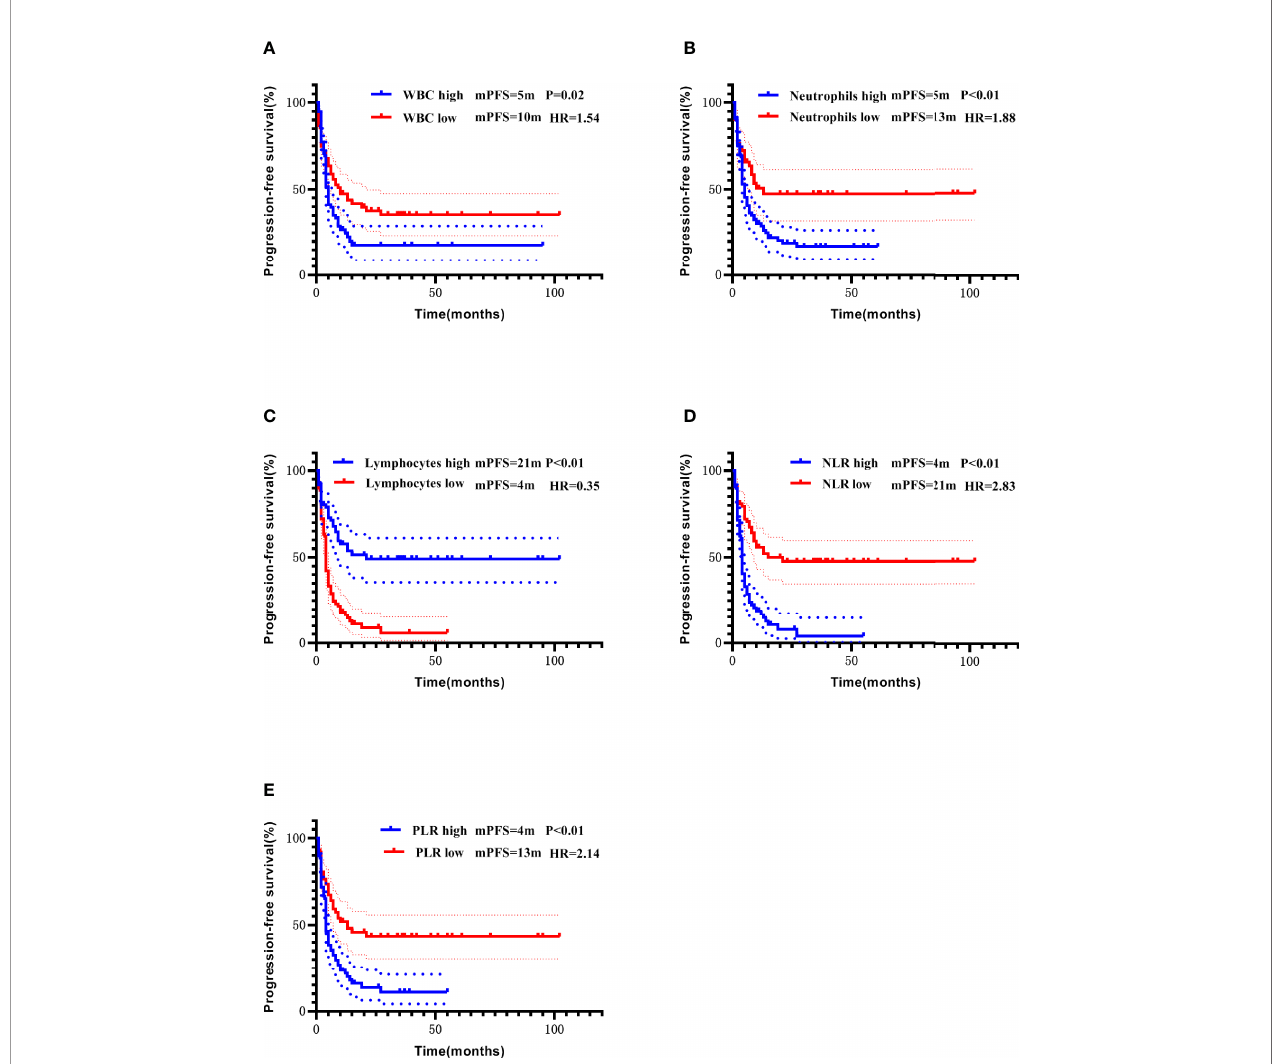
FIGURE 7 | Correlation of white blood cells count (A) , neutrophils count (B) , lymphocytes count (C ), NLR (D) , and PLR (E) with PFS addressed by the Kaplan- Meier method and log-rank